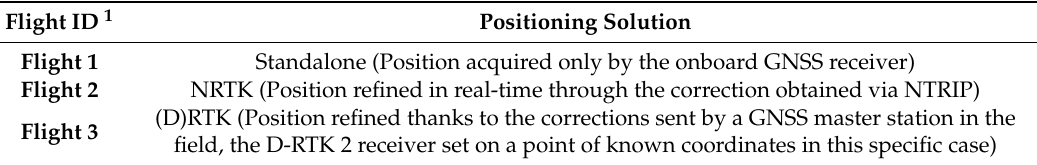
Table 6. Positioning solution adopted during the different flights performed.